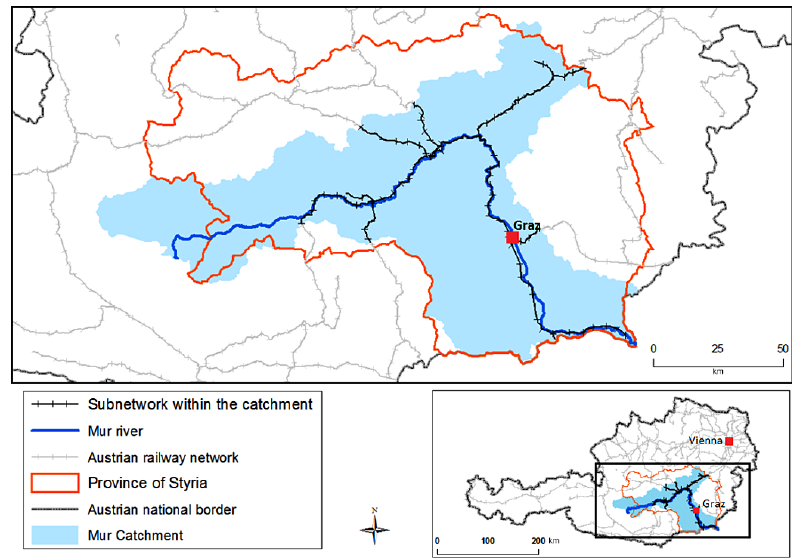
Figure 2. Location of the Mur catchment and the railway network under